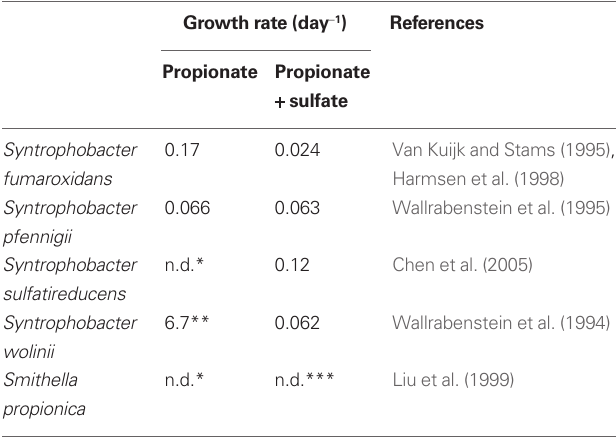
*Capable of syntrophic growth on propionate, but growth rate not determined. **Only a doubling time (days) was determined. ***Capable of sulfate reduction, but growth rate not